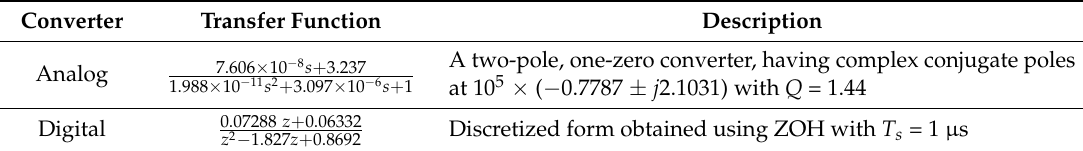
Table 1. Buck converter transfer